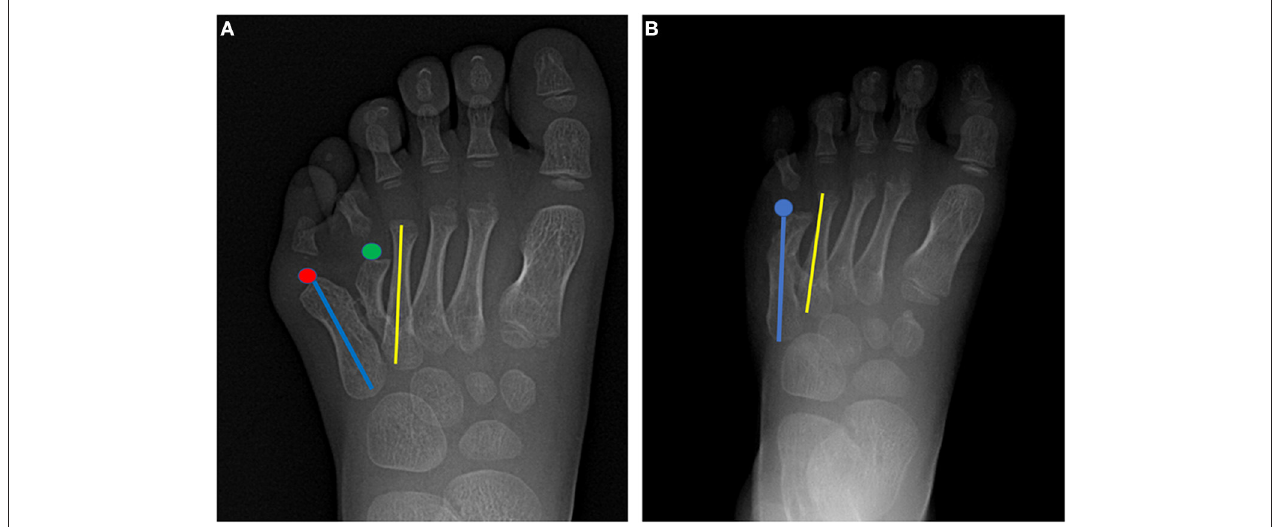
FIGURE 4 | Pre- and postoperative radiographs for comparison of foot morphology. (A) The red dots represent the centers of the lateral metatarsal bones, and the green dots represent the centers of the medial metatarsal bones. The blue line represents the axis of the fifth metatarsal, and the yellow line represents the axis of the fourth metatarsal. (B) The blue line represents the axis of the fifth metatarsal bone after surgery. The blue dot represents the center of the fifth metatarsal bone after surgery; the sequence of the fifth toe line returned to normal after surgery.